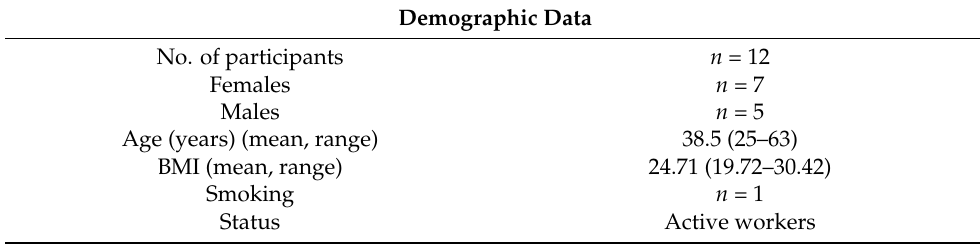
Table 1. Demographic data of the participants.